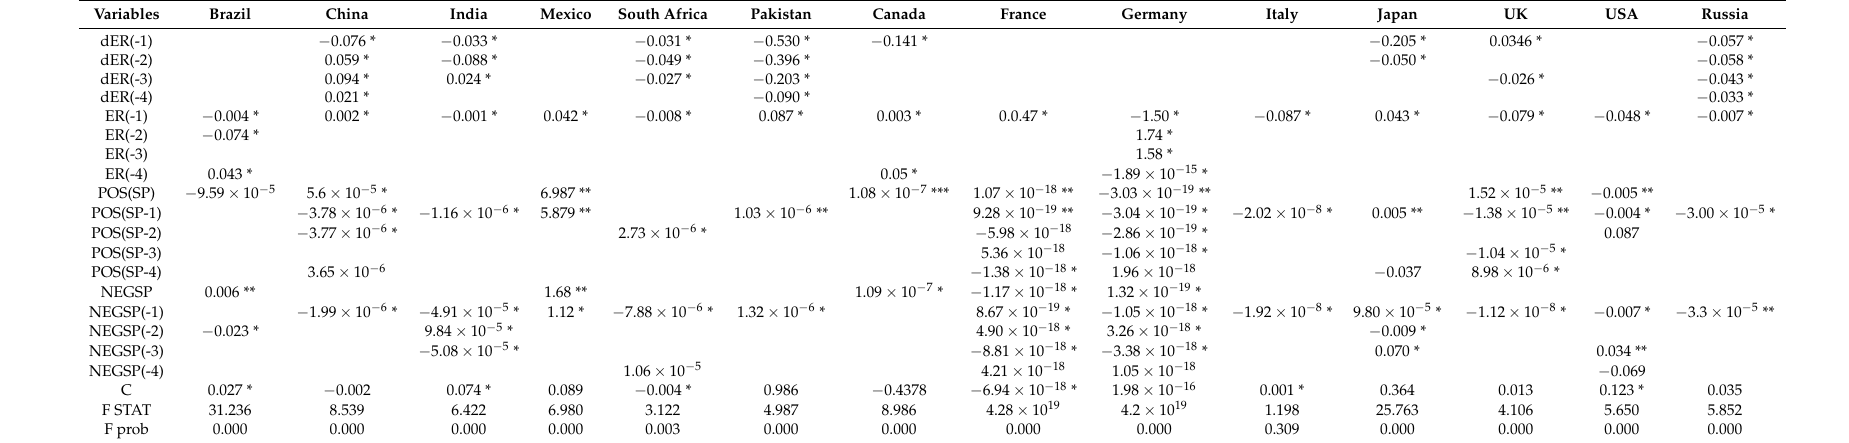
Table 5. Non-linear ARDL (NARDL) dependent variable: exchange rate.